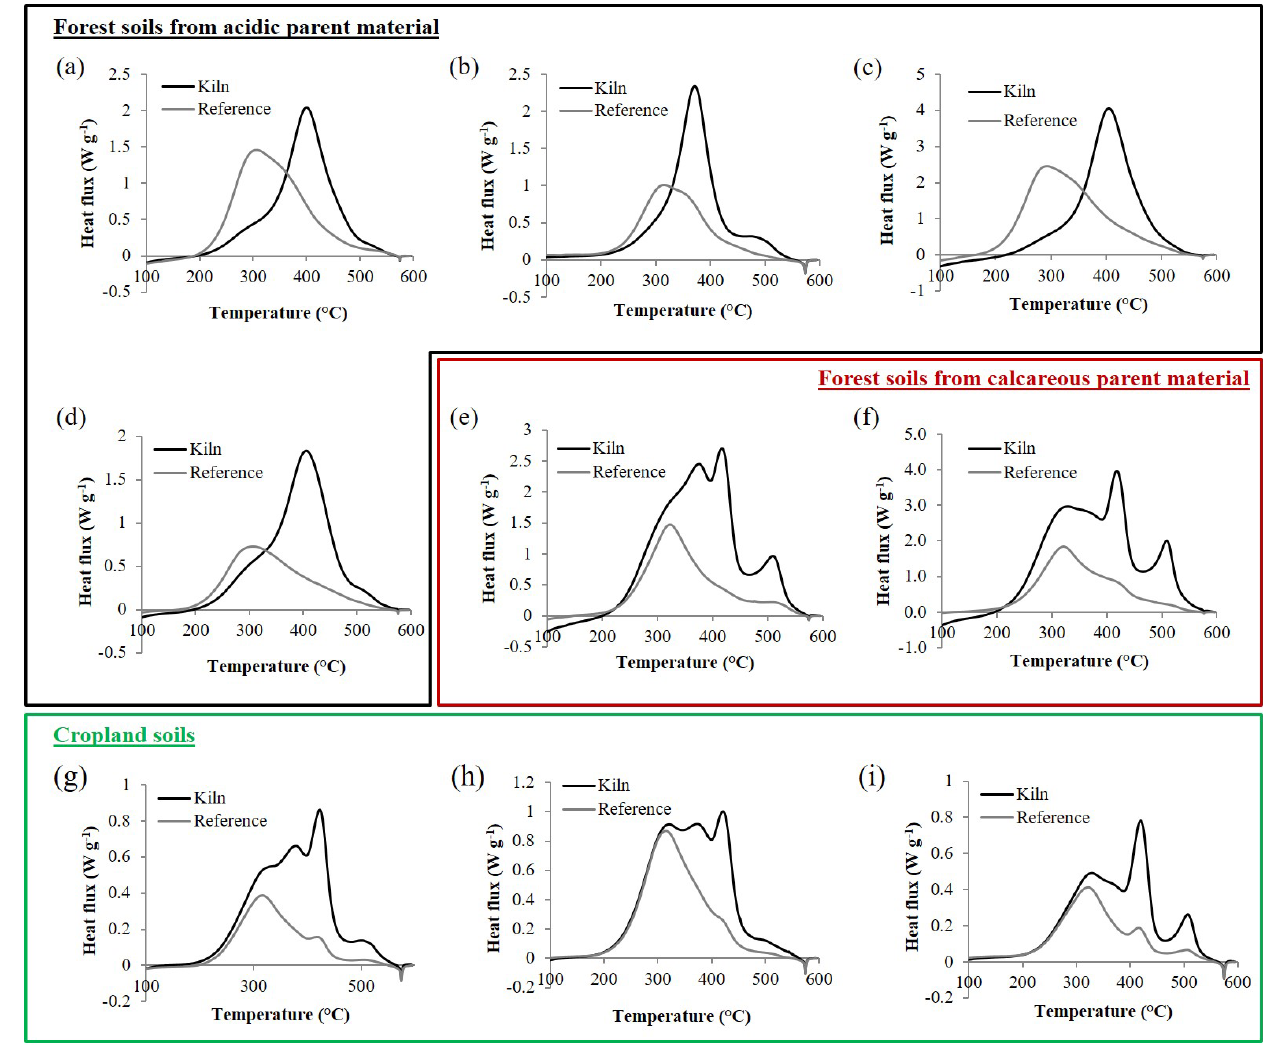
Figure 2. Differential scanning calorimetry thermograms of a representative selection of soils from pre-industrial charcoal kiln sites (black curves) and adjacent reference soils (grey curves). Four sites were located on (very) acidic forest soil (a–d) , two sites were located on calcareous forest soil (e–f) and three sites were located on cropland soils (g–i) .